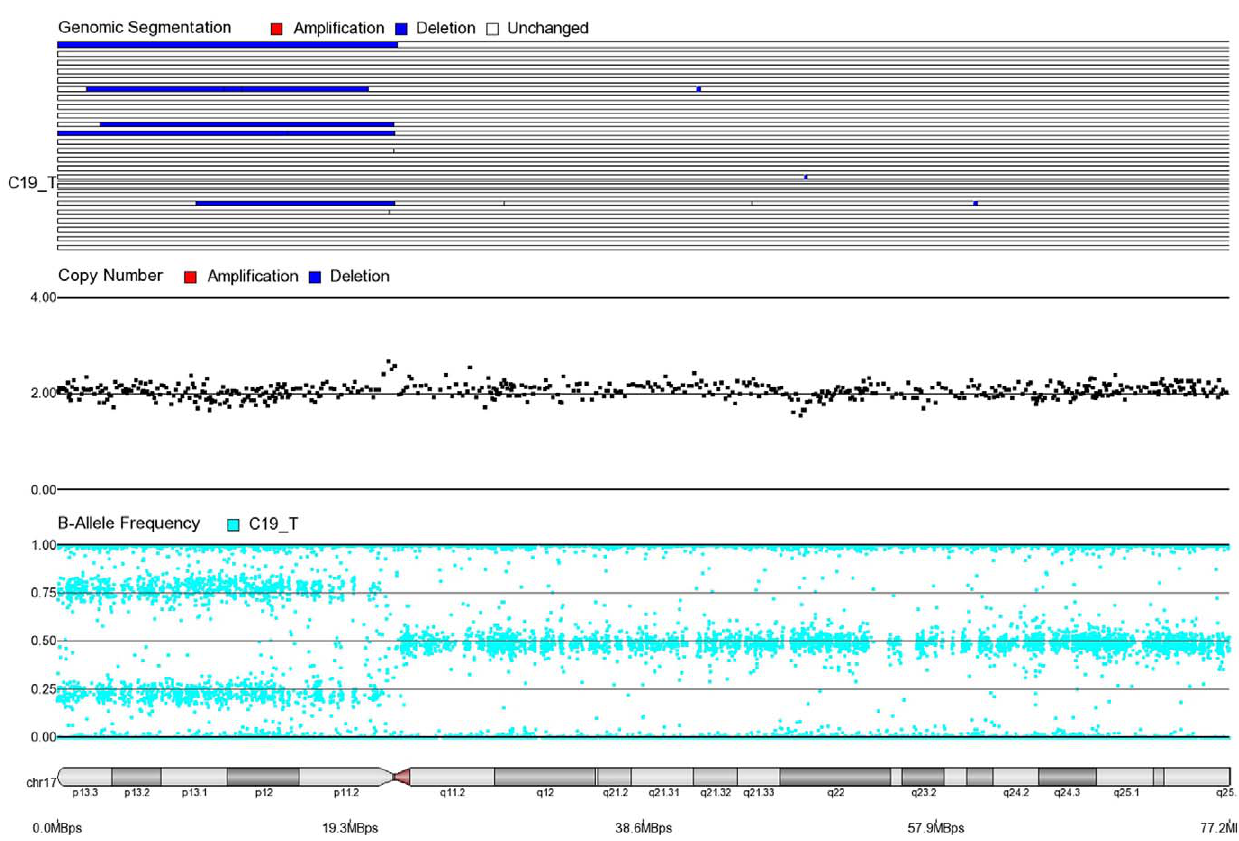
Figure 6. Mosaic cnLOH in chromosome 17 for CRC tissue sample C17_T. Note that 17p shows the normal heterozygote pattern in all cells (BAF=0.5 and CN=2) but approximately 50% of cells show cnLOH (AA or BB) in 17q (BAF=0.25, 0.75 and